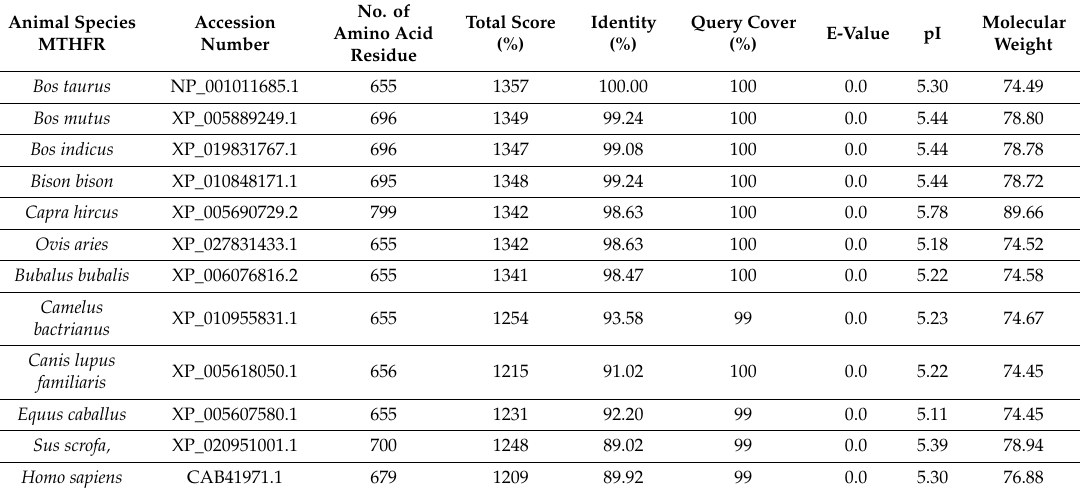
Figure 4. Phylogenetic tree of MTHFR among closely related species.